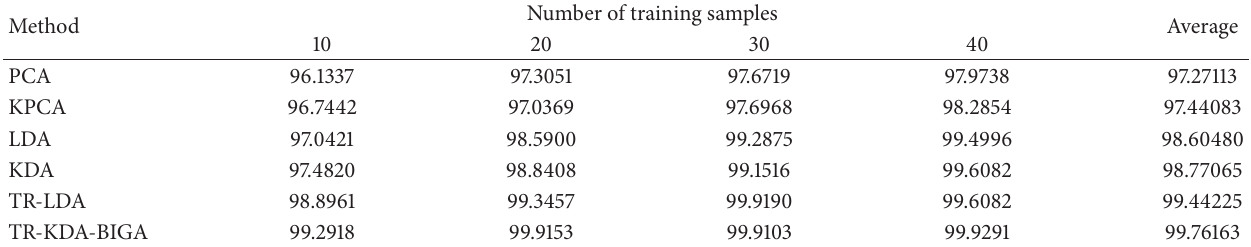
Table 7: Classification accuracy of bearing data under 3 HP motor